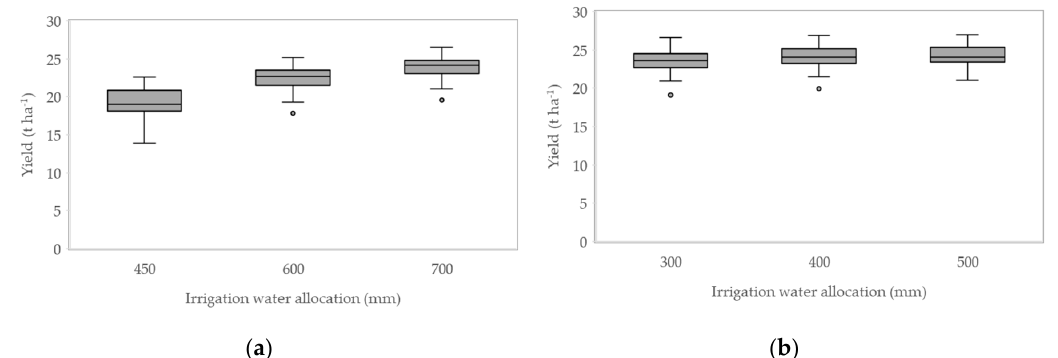
Figure 6. Potential dry root yield at harvest under three different irrigation water allocation scenarios for the 30 simulated seasons in the two main productive areas: ( a ) North (Valladolid), and ( b ) South (Sevilla). The box represents 50% of the data, where the box’s upper boundary represents the upper quartile (Q3) of the data, the lower boundary represents the lower quartile (Q1), and the line inside the box represents the median (Q2). The whiskers show the largest and smallest values. The circles denote outlier values.